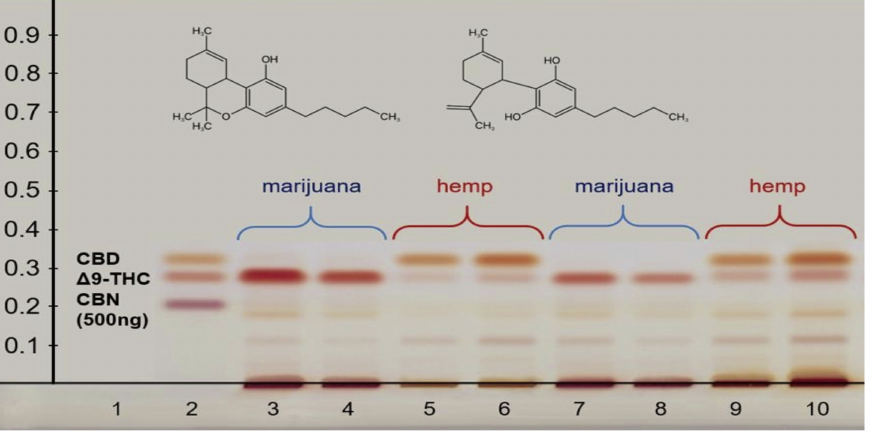
Figure 7. High performance thin-layer chromatography (HPTLC) analysis of cannabinoids. Reprinted by permission from [58]. Copyright 2020